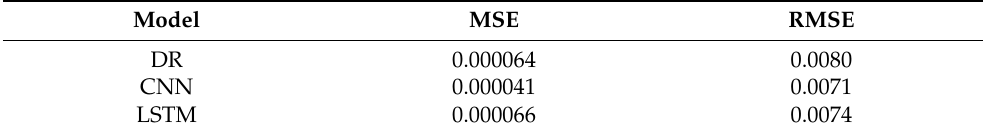
Table 1. The performance of the first